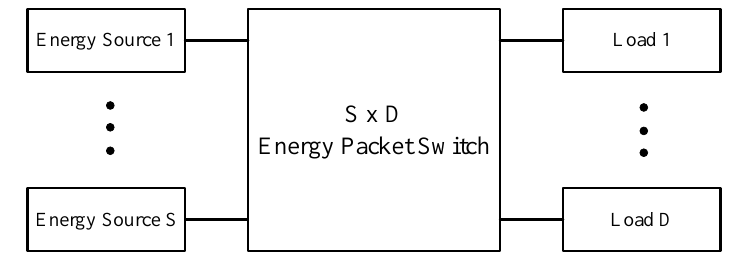
Figure 1. Example of an application of the energy packet switch.